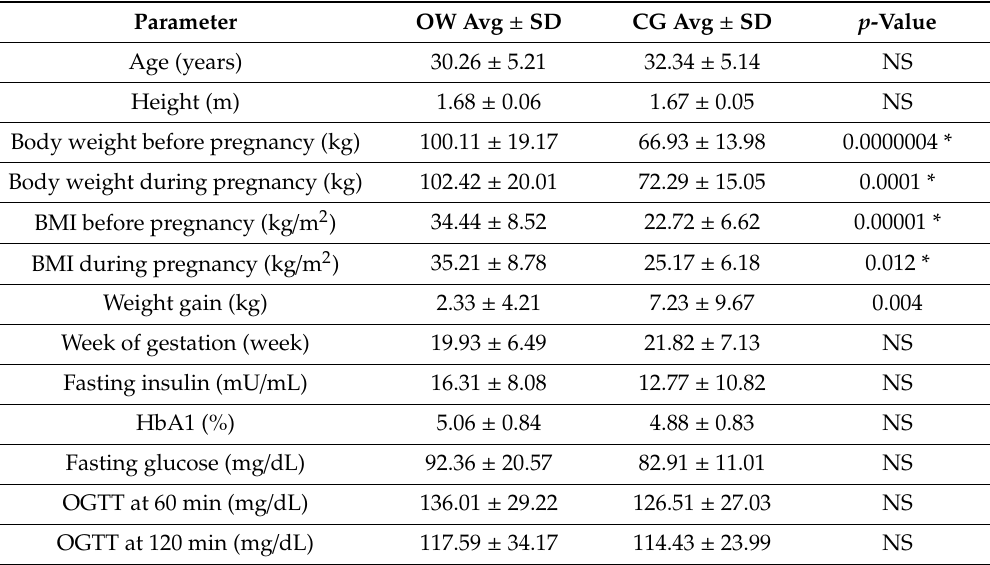
Table 7. Division of the study group of